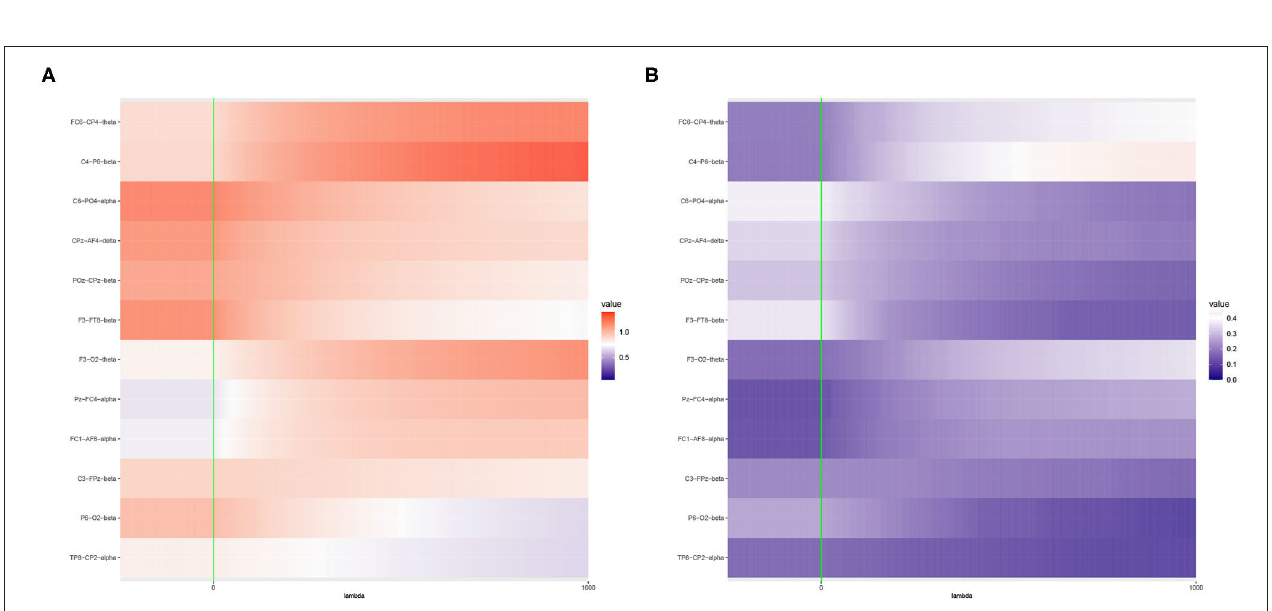
FIGURE 6 | Heat maps of (A) Average of -log 10 p -values and (B) Empirical Power of the Adaptive Mantel test using the imaging genetics data with n = 350 observations, p = 497 genetic features and coherence information from some channel-channel-band triples. The green vertical line corresponds to λ = 0.